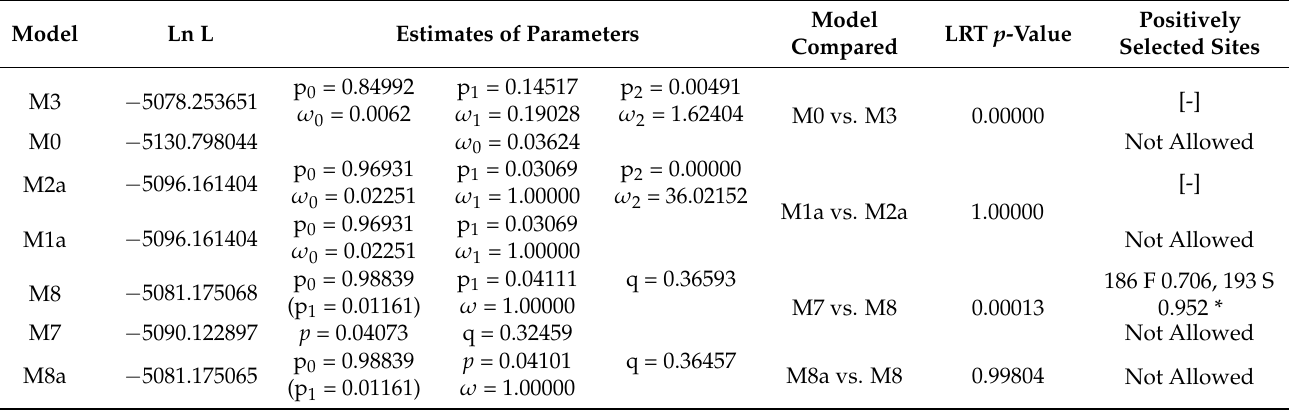
Table 4. Parameter estimates and log-likelihood values under models among sites for ND4 gene between Saurogobio branch A and Saurogobio branch